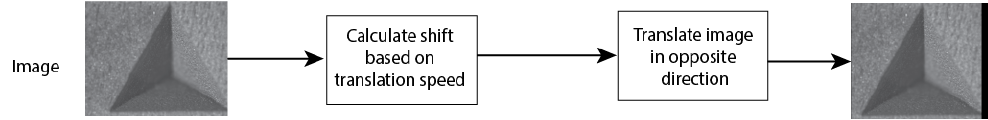
Figure 5. Alignment process of the focal stack, based on translation speed of the